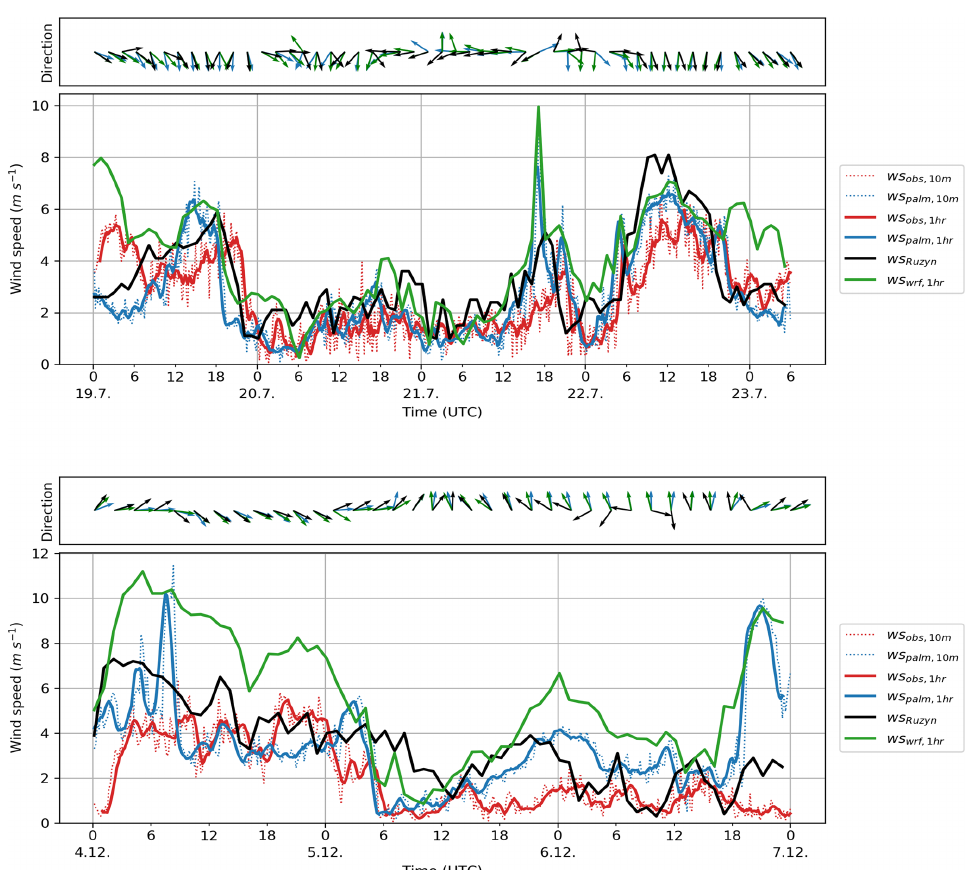
Figure 28. Time series of wind speed and wind direction on the roof of the tallest building of the Faculty of Civil Engineering of the Czech Technical University for the summer e2 (top) and winter e3 (bottom) episodes. The graphs show wind speed, and the boxes of arrows show wind direction. The red colour represents the observations, the blue colour represents the PALM modelled values, the green colour represents values from the WRF model, and the black line represents the values from the nearest synoptic station at Praha-Ruzynˇe. Thin dotted lines represent 10min averages, and the thick solid lines are 1h moving averages of wind speed. The arrows represent 2h averages of wind direction. PALM model results are taken from the child domain with a 2m horizontal resolution.